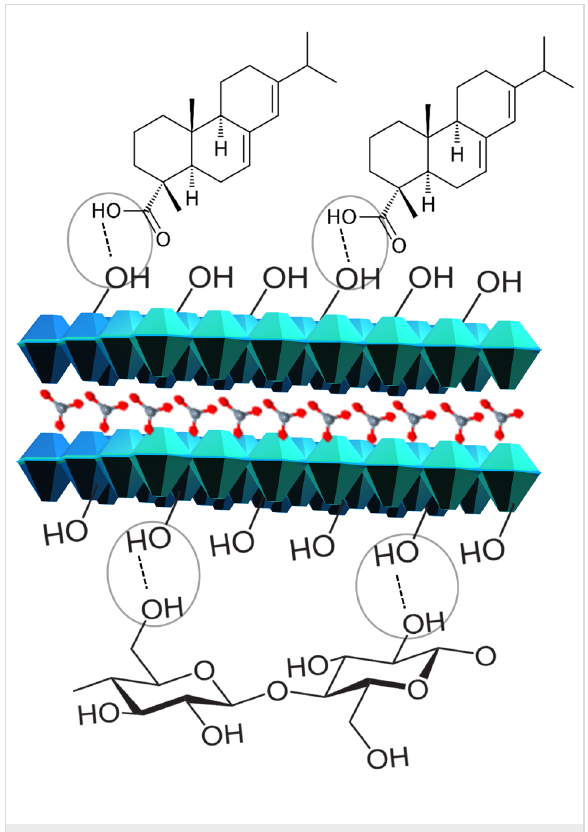
Figure 10: Hydrogen bonding directed assembly of AA on HF.